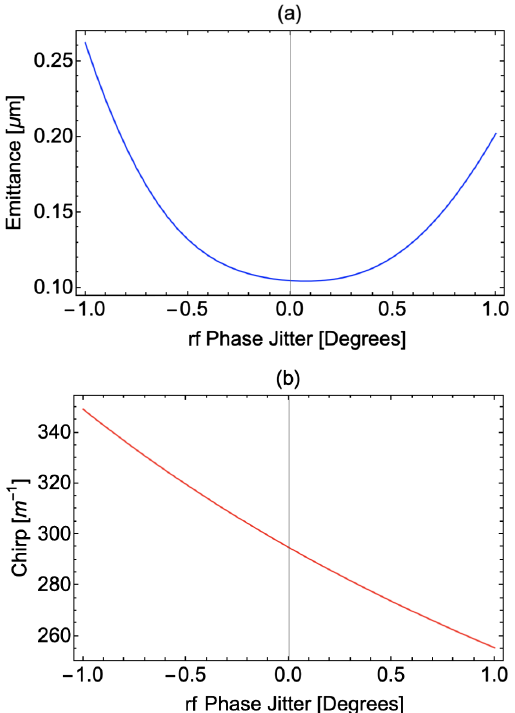
FIG. 9. Transverse emittance (a) and sensitivity of the chirp (a) to the rf phase jitter for the TCBC design at 250 MeVand the largest anticipated imposed